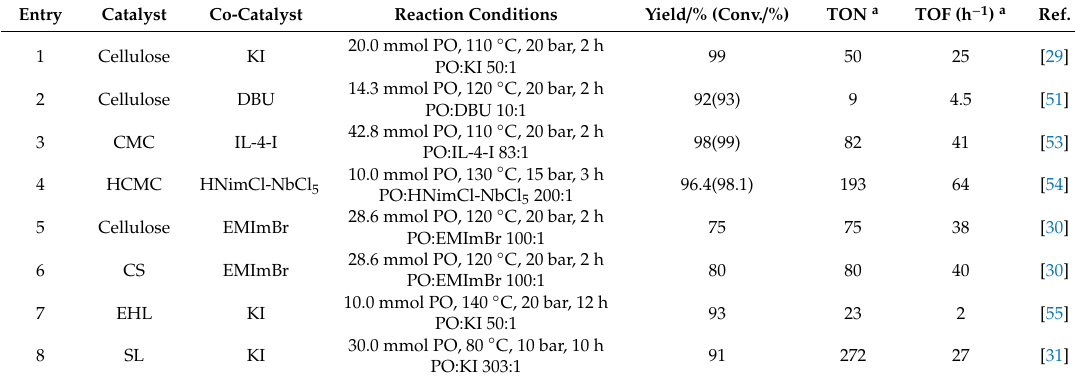
Table 2. Summary of reaction conditions and yields for epoxides conversion to cyclic carbonates using biomass / co-catalysts (propylene oxide (PO)).